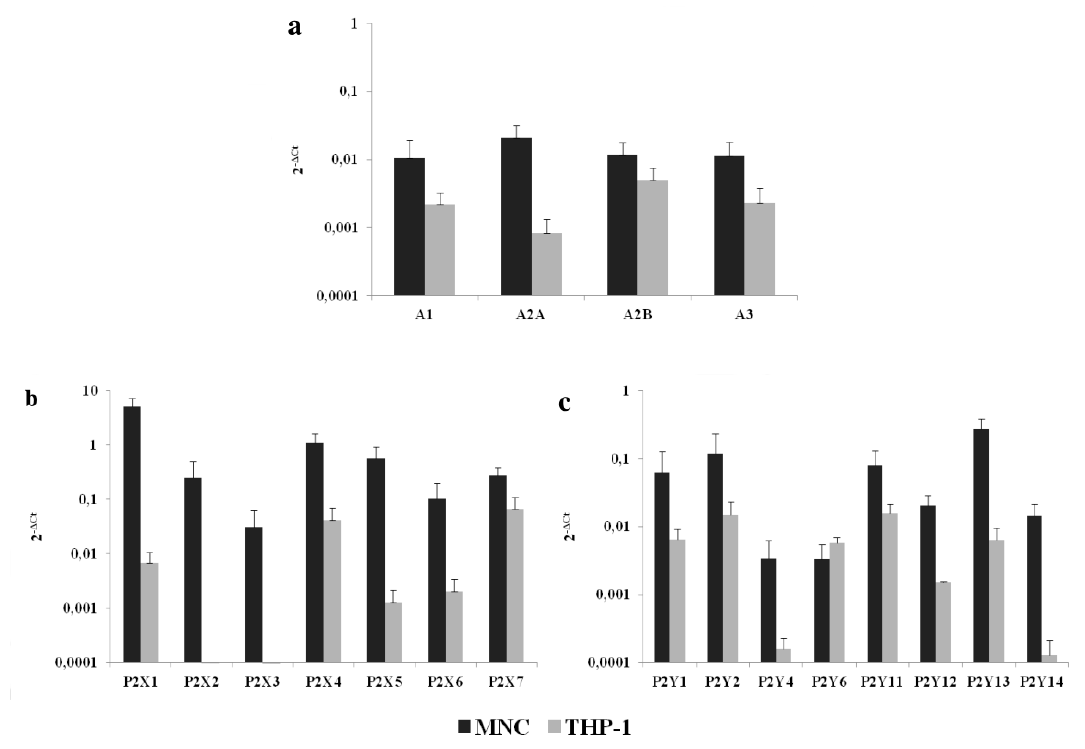
Figure 1. The mRNA expression of ( a ) P1, ( b ) P2X and ( c ) P2Y receptors in mononuclear cells (MNCs) and THP-1 cells. Data are presented as the mean ±